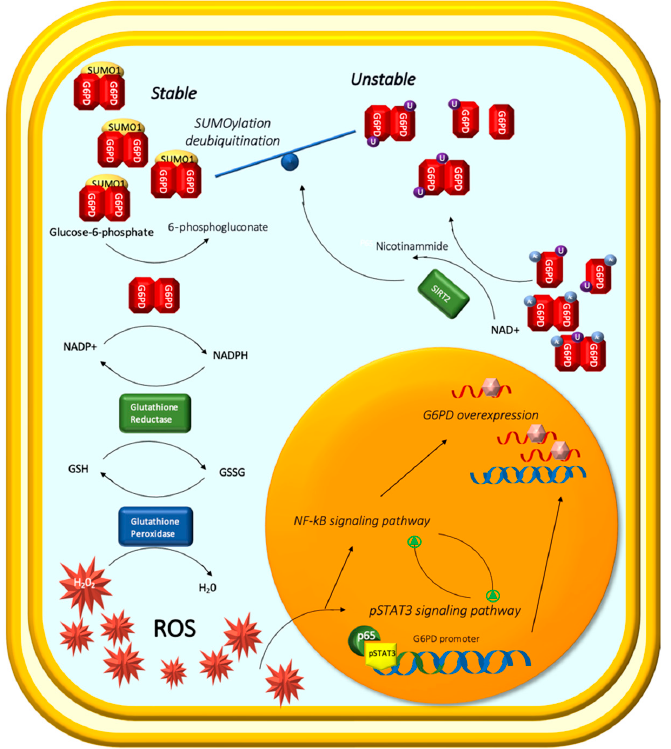
Figure 2. High levels of G6PD suggest that this pathway plays a major role in metabolic changes caused by